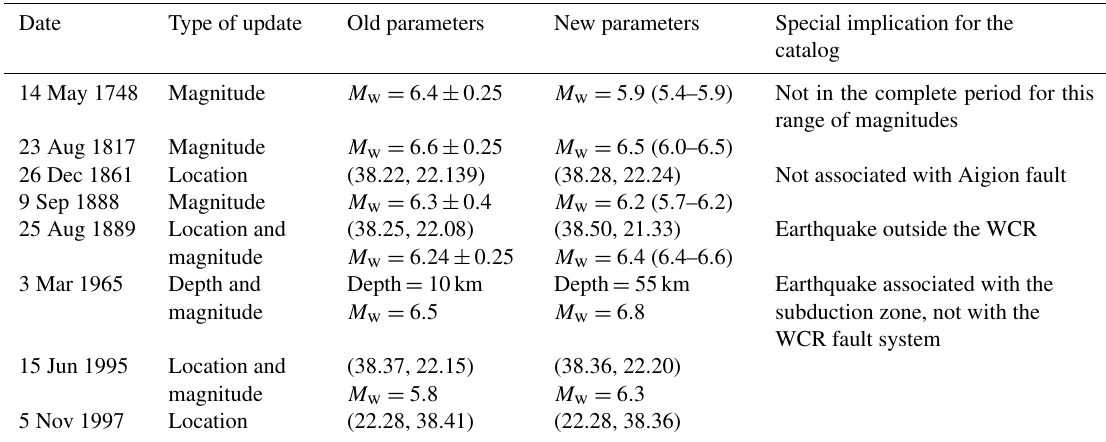
Table 3. Earthquakes updated in the historical and instrumental catalogs of the western Corinth rift.